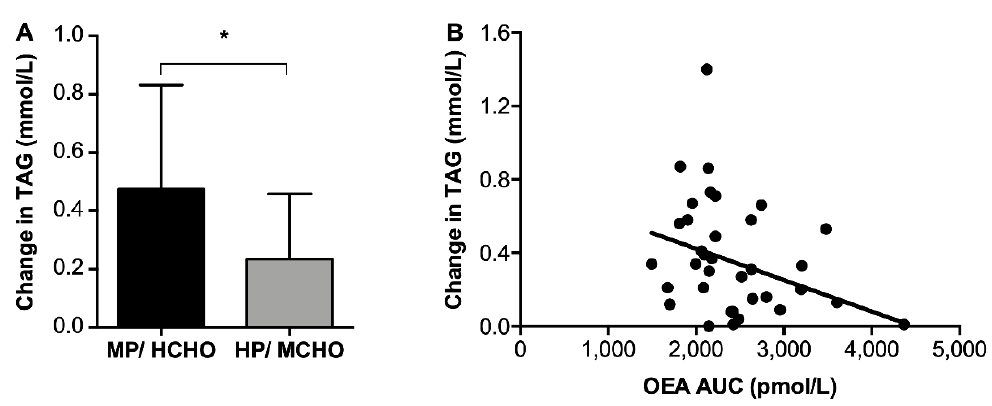
Figure 3. (A) AUC of change in TAG over 48 h in the MP/HCHO (black) and HP/MCHO (grey) group and ( B) inverse association of OEA concentrations throughout the day and the change in TAG over 48h. Values are means ± SD. MP/HCHO = moderate protein/high carbohydrate; HP/MCHO = high protein/moderate carbohydrate; TAG: triacylglycerol; OEA: oleoylethanolamide. * p <